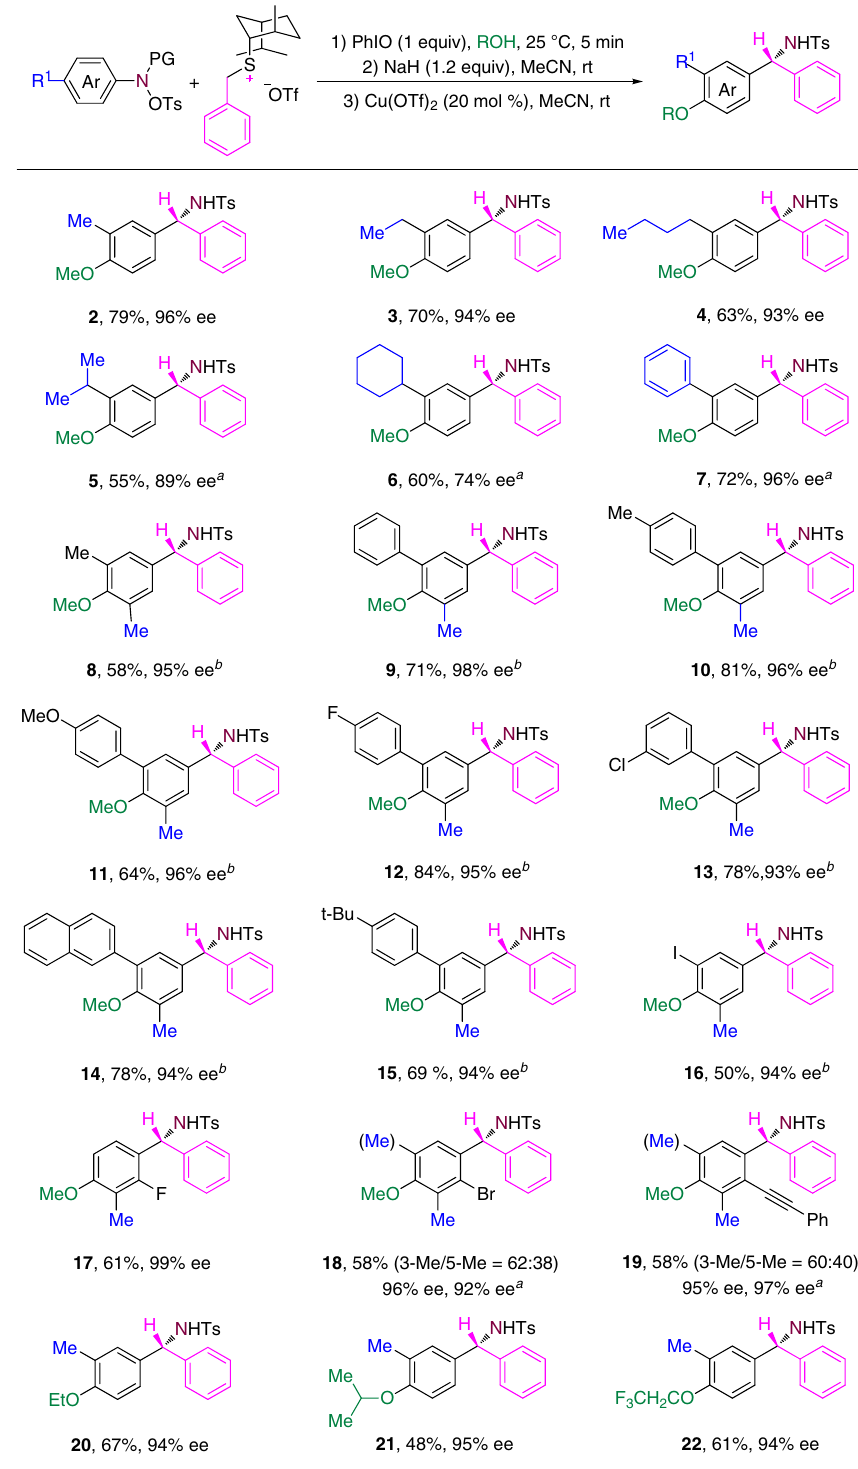
Fig. 4 Scope of anilines. Ts